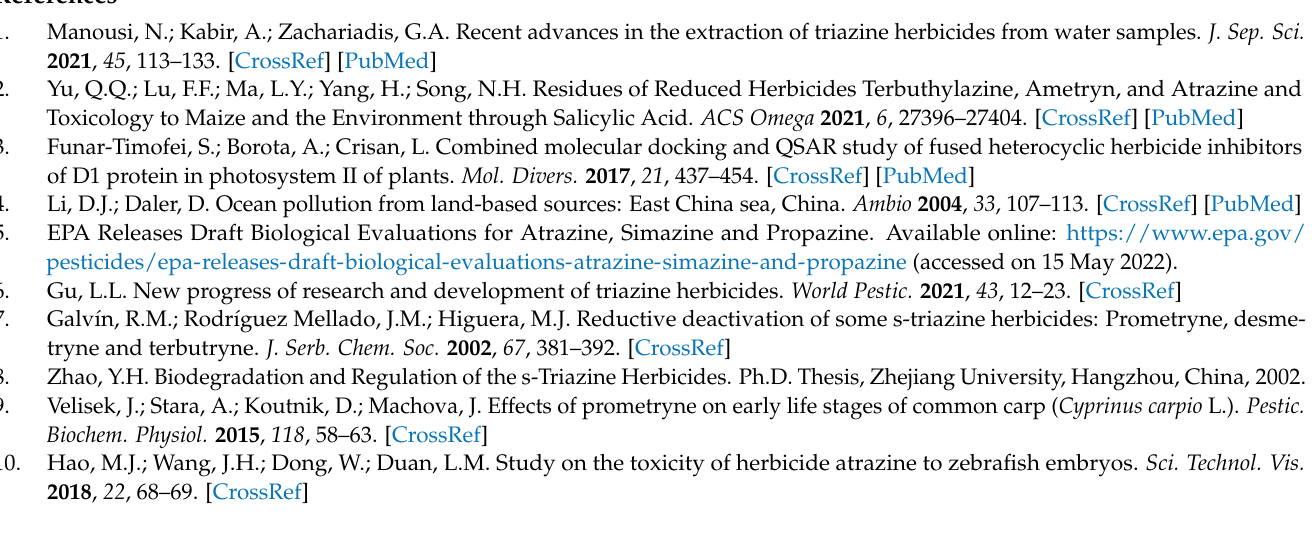
backbone of PRZ; Figure S4: Microbial degradation pathway of ATZ; Table S1: Docking scores hensive value; Table S2: Molecular combination of the CoMSIA model training sets and test sets; Table S3: Substitution sites and substituent groups for the design of molecular substitutes to S-THs; Table S4: Predicted values of herbicidal, degradative, and toxic effects of molecular substitutes to S-THs, their comprehensive effects, and rates of change; Table S5: The LDS values and their rates of change for the microbial degradation pervasiveness of molecular substitutes to S-THs; Table S6: Comprehensive values of the toxic effects of molecular substitutes to S-THs on the antiox- idant system of fish; Table S7: Molecular dynamics simulations of the external condition addition scheme (18 factors/2 levels) based on the Taguchi orthogonal experiments; Table S8: Response and effect values for the external condition addition scenario (3 factors/2 levels); Table S9: Evaluation of the aquatic toxicity of D-5 microbial degradation products based on the EPI software method; Table S10: Human health risk assessment of D-5 microbial degradation products based on pharma- cokinetic and toxicokinetic data; Table S11: CoMSIA model evaluation methods and model evaluation criteria; Table S12: Nitrogen fertilizer and maize root secretion and their corresponding